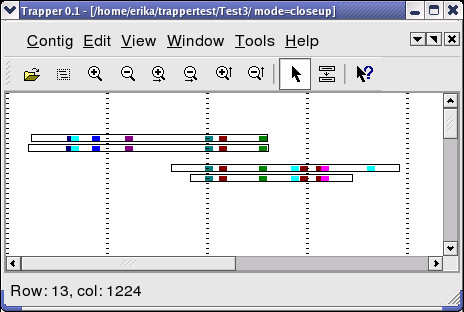
DNP walking. Manual repeat resolution is carried out by starting with a read and locating other reads with the same DNP pattern. The repeat group is extended to the right and left by locating reads with the same DNPs at the ends of the reads. In this simple example, the two top reads constitute the beginning of a repeat group. The group is extended by identification of the same DNP pattern in the left end of the two bottom reads. This can be done by eye or searching the alignment for reads with the same DNP ID.